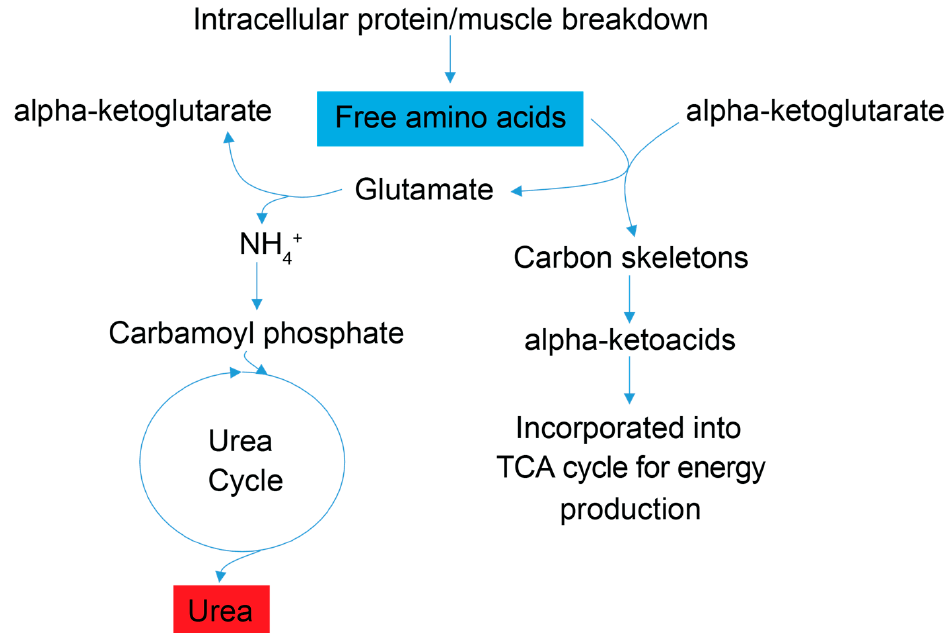
Figure 3. Simplified schematic of amino acid catabolic pathways used for ATP production. Enhanced amino acid degradation, a signature of energetic needs, is supported by an increased concentration of urea in FD patient sera. As indicated by enhanced catabolism of the amino acids alanine and as- paragine, and the BCAAs valine, leucine and isoleucine, all trending to be lower (blue). Subsequently, a byproduct of the catabolism of amino acids for energy homeostasis is urea (red), which is then excreted. Red metabolites are increased in FD patient sera, and blue metabolites are